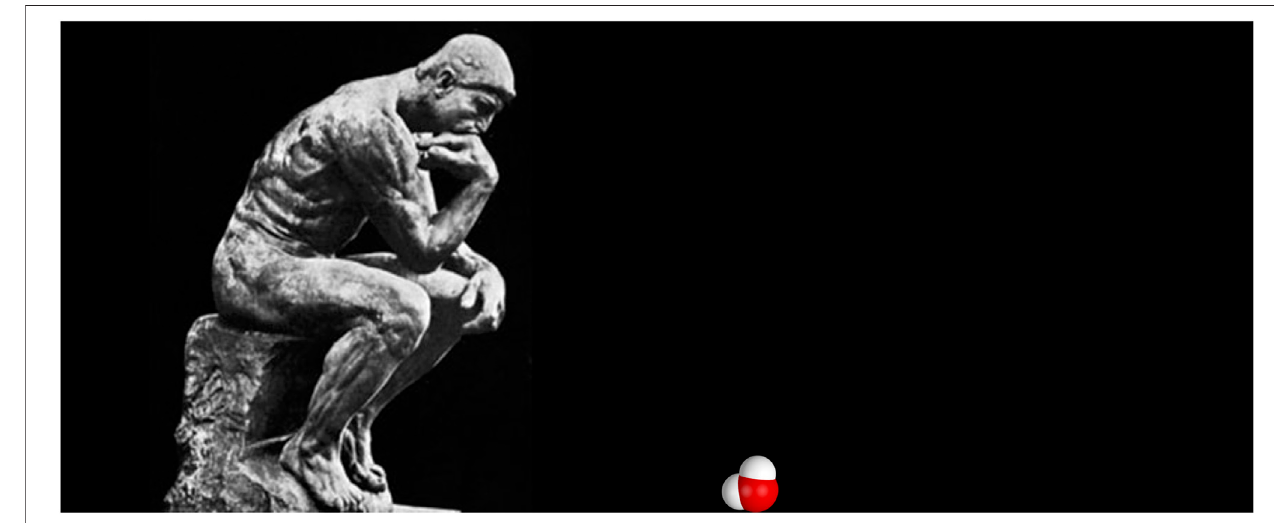
FIGURE 1 | In the construction of a model we are confronted with several questions, whose apparent philosophical quality entails a rather practical nature. In particular, we ask ourselves: Can one always coarse-grain? Is there an optimal level of resolution? Is a single level of resolution meaningful? How to identify the optimal resolution level or distribution? And how can we implement it in practice? (In the picture: “ The thinker ” , A. Rodin, 1904).